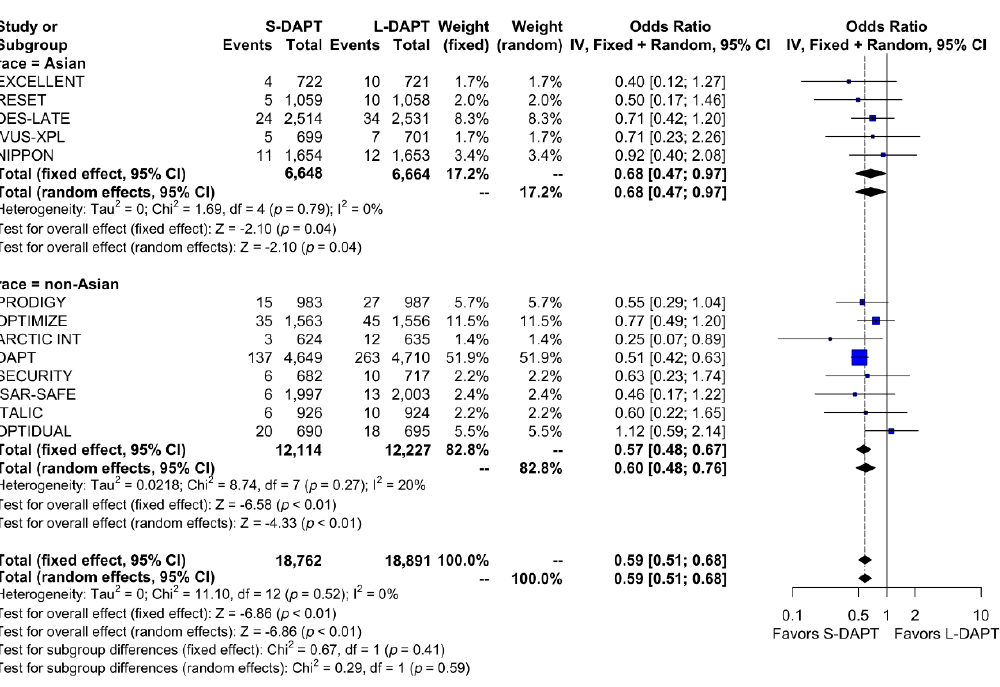
Figure 7. Bleeding in randomized clinical trials. S-DAPT, short duration dual antiplatelet therapy; L-DAPT, long duration dual antiplatelet therapy; CI, confidence interval.